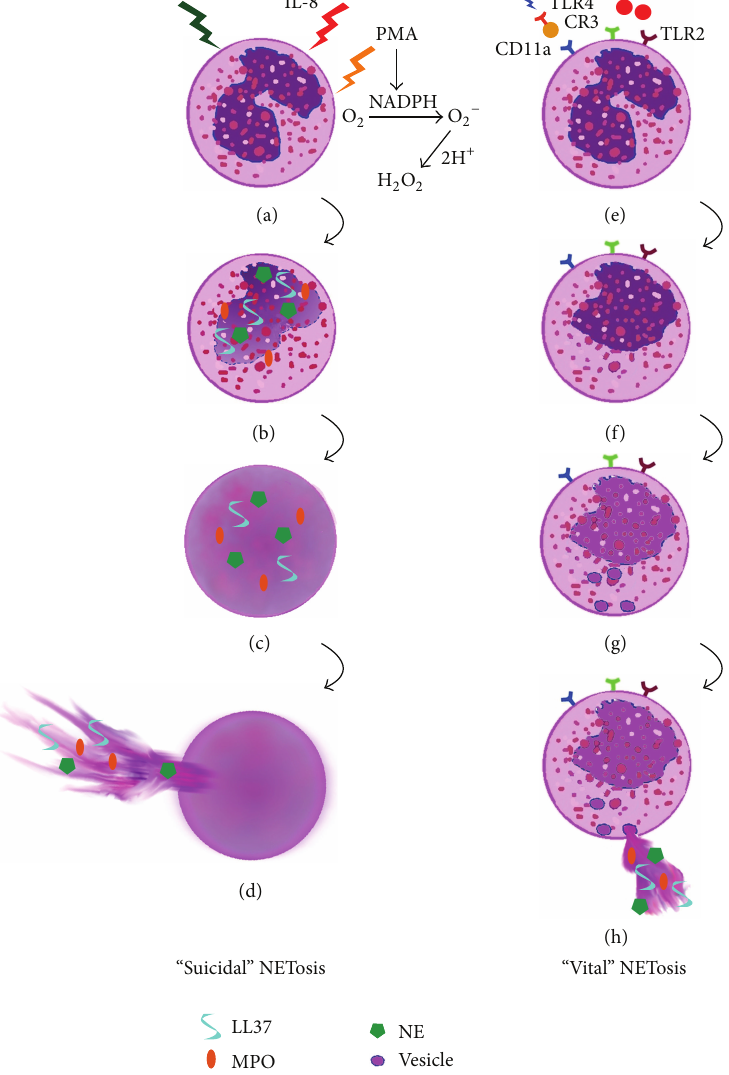
Figure 2: Mechanisms of NET formation: vital versus suicidal NETosis. (a)–(d) The “suicidal” NETosis starts after a stimulation by, for example, PMA, IL-8, or various microbial pathogens in a NADPH-oxidase-dependent matter and leads to NET release within 1 to 4 h. Translocation of MPO, elastase, and LL-37 to the nucleus leads to the nuclear decondensation and disruption of the nuclear membrane [78, 79]. Subsequently, the content of the nucleus mixes with the granular as well as cytosolic proteins. Finally, the outer membrane ruptures and NETs are released by the activated neutrophils into the extracellular space. (e)-(f) The “vital” NETosis has been described to be a rapid release of NETs (5–60min). It can be induced by a TLR-4-mediated platelet activation and its interaction with CD11a on neutrophils [38]. Furthermore, an activation via complement receptor 3 (CR3) and TLR-2 has also been shown in the presence of Gram-positive bacteria, for example, Staphylococcus (S.) aureus [35]. The nucleus becomes rounded and decondensed (f). Vesicles with nuclear DNA are formed (g) and NETs are released via nuclear budding (h). The outer membrane remains intact upon NET release and the anuclear neutrophil retains the ability to multitask [35] (adapted